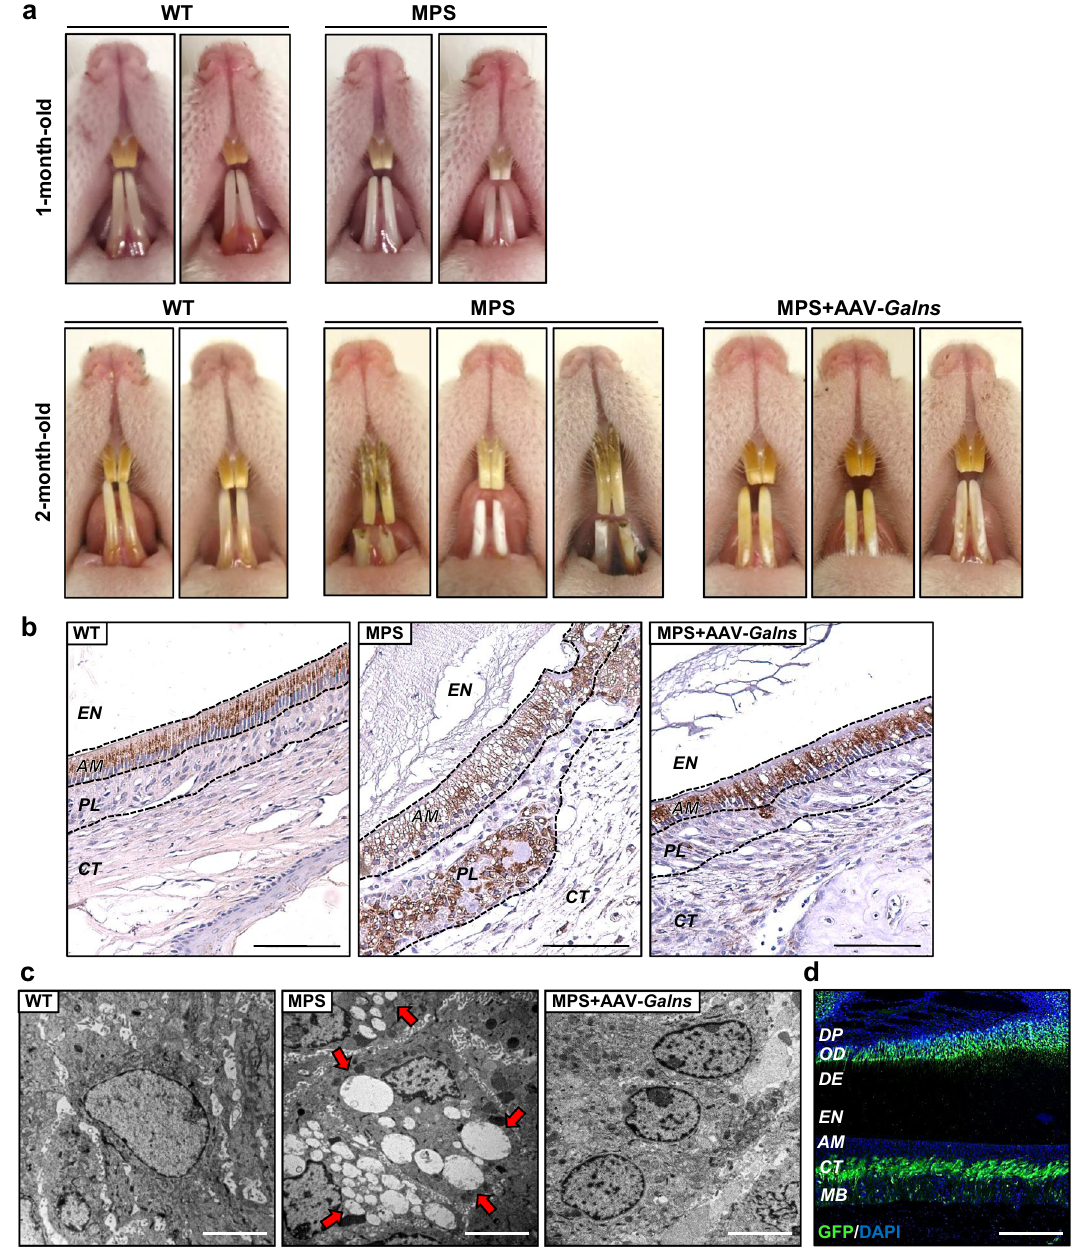
Fig. 4 Treatment with Galns -encoding vectors counteracts dental pathology. MPSIVA rats were treated intravascularly with 6.67 × 10 13 vg/kg AAV9- Galns vectors at 4 weeks of age. a Incisors from 1-month-old WT and MPSIVA rats presented similar morphology. At two months of age, incisors of MPSIVA rats presented malocclusion, dental fragility, and enamel hypoplasia, while incisors of MPSIVA treated rats were similar to those of WT rats. b LIMP2 immunohistochemistry of incisor in mandible sections from 2-months-old WT ( n = 2), untreated ( n = 3), and AAV9- Galns- treated ( n = 2) MPSIVA rats. Untreated MPSIVA rats presented a marked lysosomal distension and vacuolization in ameloblast and papillary cell layers. Treatment of MPSIVA rats with AAV9- Galns prevented ameloblast lysosomal pathology. Scale bars: 100 µ m. EN enamel, AM ameloblasts, PL papillary layer, CT connective tissue. c Ultrastructural analysis of incisors of 6-months-old rats. Ameloblast cells from incisors of untreated MPSIVA rats presented large electrolucent vacuoles (arrows), which were absent in AAV9- Galns -treated MPSIVA ameloblasts. n = 2 animals/group. Scale bars, 5 µ m. d GFP immunostaining in incisors 2 weeks after administration of AAV9- GFP vectors (6.67 × 10 13 vg/kg) to 4-weeks-old rats. n = 3 animals/group. DP dental pulp, OD odontoblasts, DE dentine, MB mandibular bone. Scale bars, 200 µ m. Source data are provided as a Source Data fi